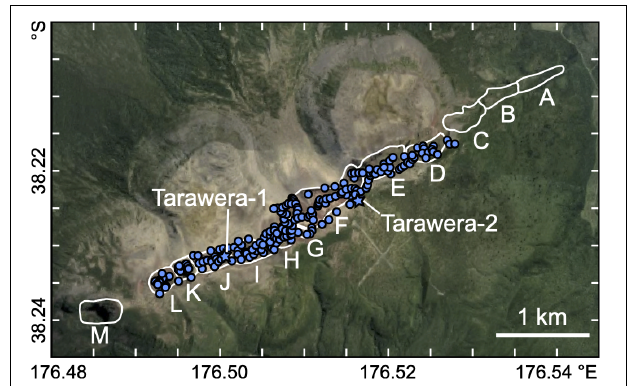
FIGURE 2 | Locations of CO 2 flux measurements at Tarawera with craters (white, solid outline) labeled after Sable et al. (2006). Stars indicate location of isotope samples (Tarawera-1 and Tarawera-2). Image from Google